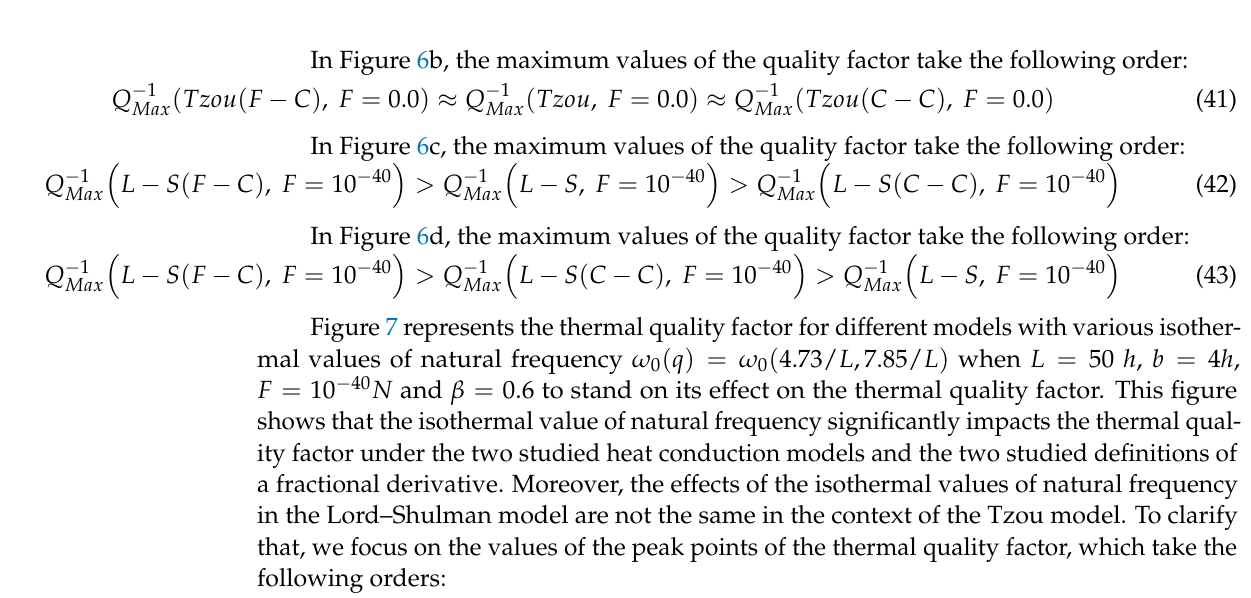
Figure 6. The thermal quality factor for different models with various values of the force due to static prestress when